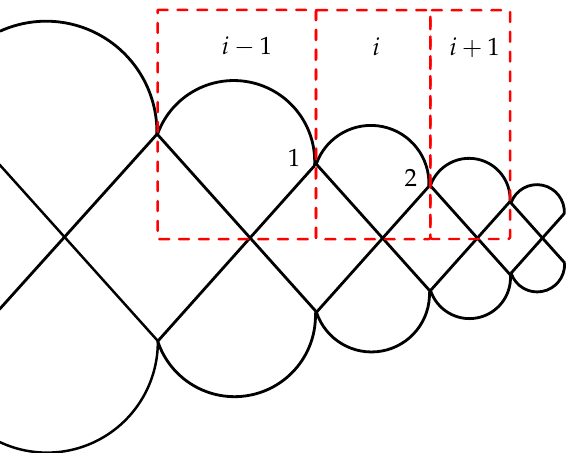
Figure 13. Segments i − 1, i and i + 1 of the tapered woven